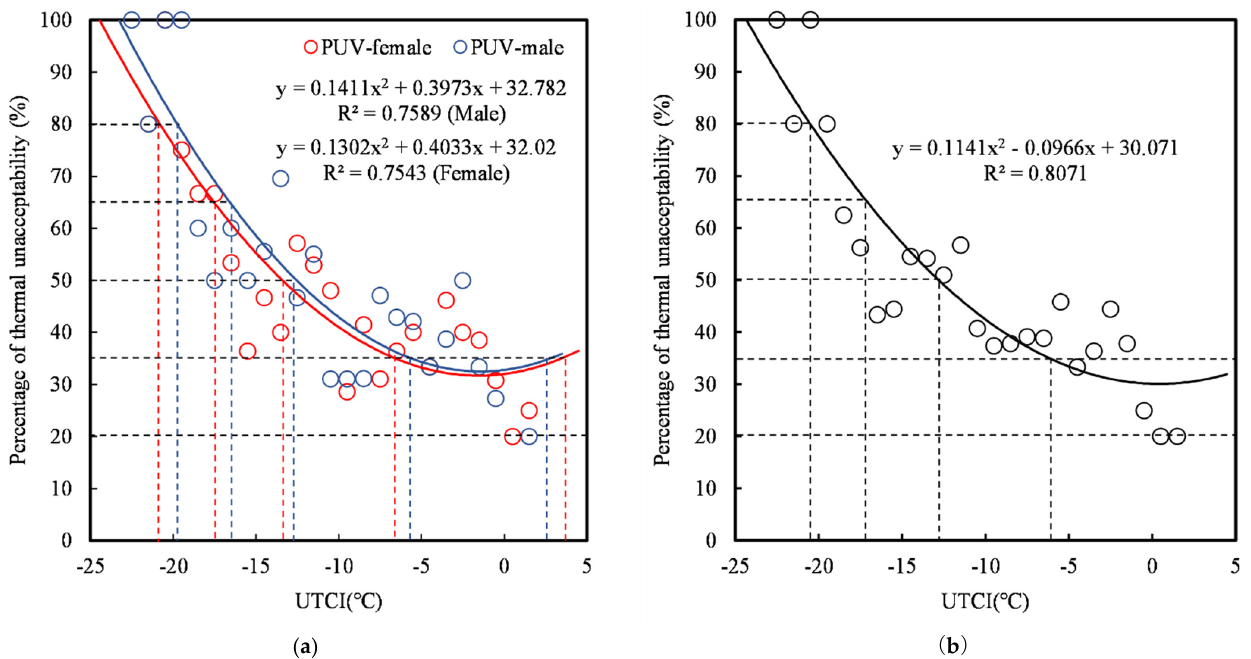
Figure 9. Thermal unacceptability rate vs. UTCI: ( a ) female and male subjects and ( b ) all.